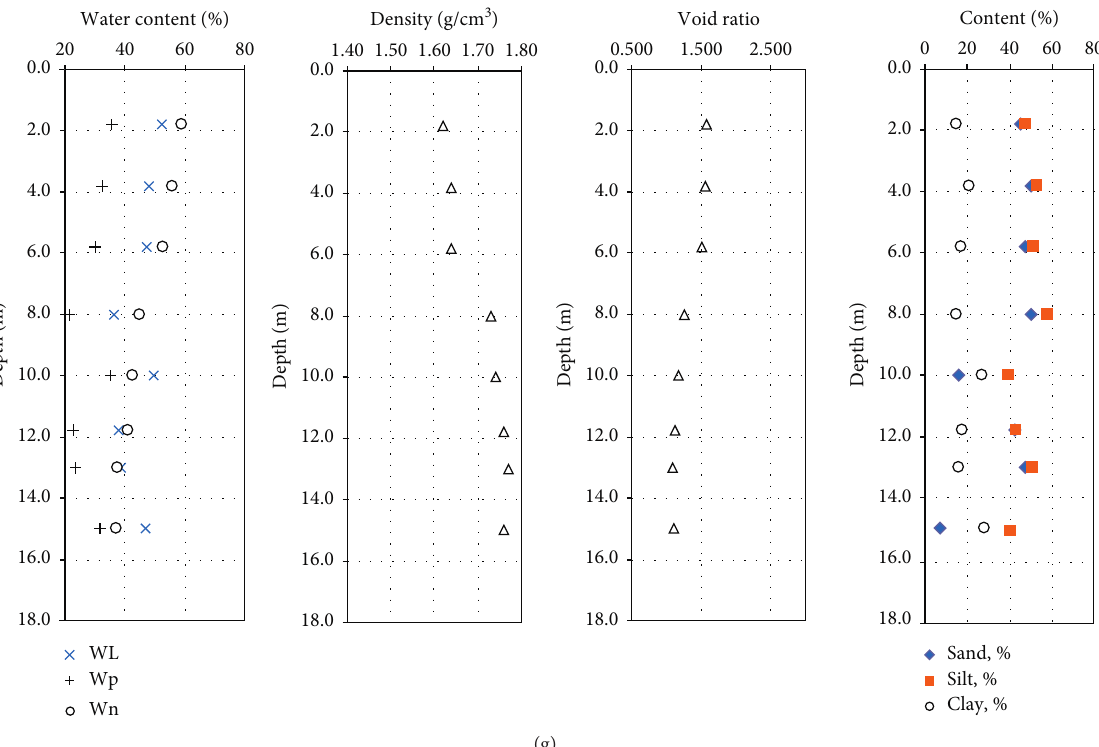
Figure 2: (a) The physical properties and particles of soft clay in Tien Giang province (Site 2). (b) The physical properties and particles of soft clay in Tra Vinh province (Site 3). (c) The physical properties and particles of soft clay in Soc Trang province (Site 4). (d) The physical properties and particles of soft clay in Ca Mau province (Site 6). (e) The physical properties and particles of soft clay in Kien Giang province (Site 7). (f) The physical properties and particles of soft sandy clay in Ha Tinh province (Site 1). (g) The physical properties and particles of soft sandy clay in Soc Trang province (Site